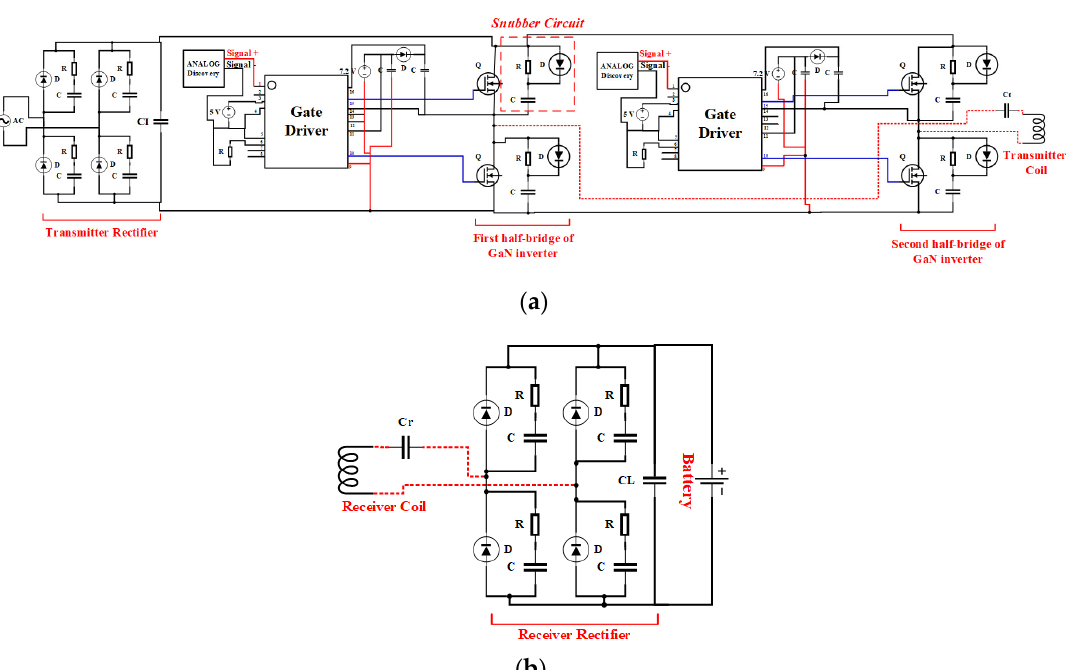
Figure 1. Wireless charging circuit contains: ( a ) AC voltage source, transmitter rectifier, GaN inverter with gate drivers, and transmitter coil; ( b ) Receiver coil, receiver rectifier, and battery.